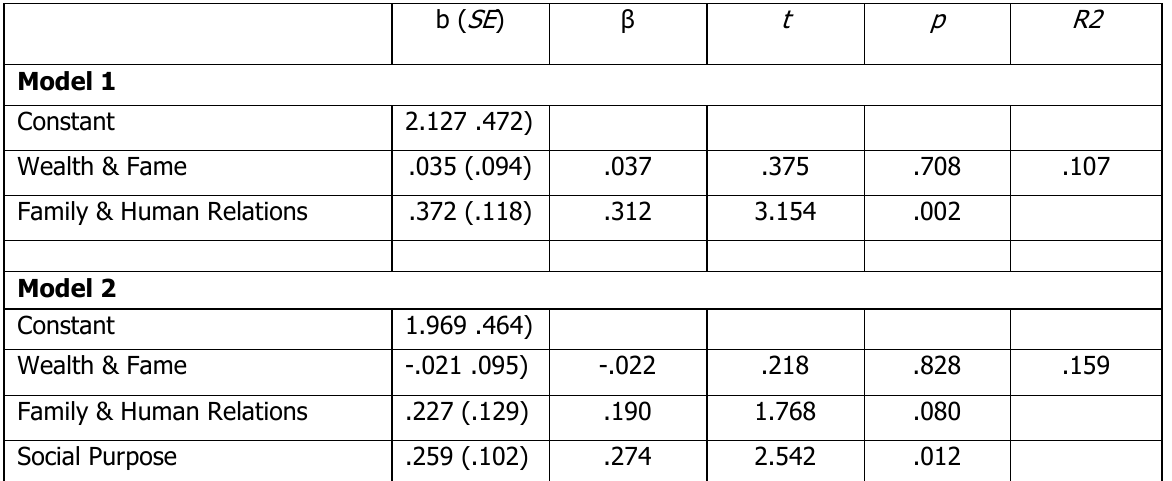
Hierarchical regression of the three life goals on life meaning (n =